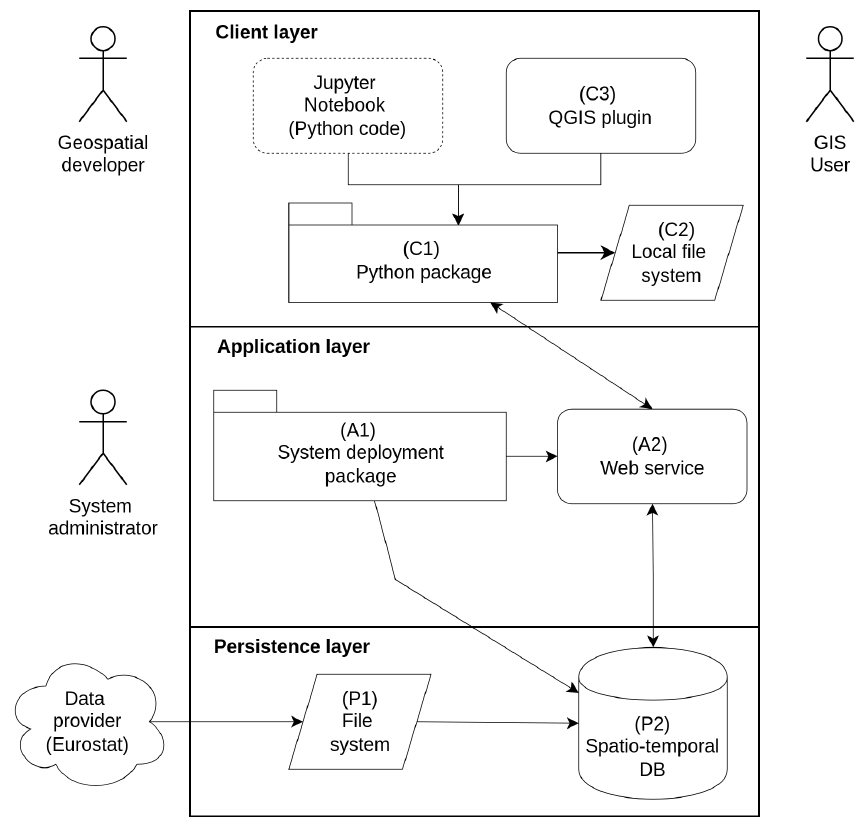
Figure 3. Static high-level architecture of the ST_LUCAS system. The Jupyter Notebook (dotted line) is not intended to be a software component. The Jupyter Notebook is used in this work to present the functionality of the Python package (C1) and to provide manual verification. Table 1. Overview of the ST_LUCAS system